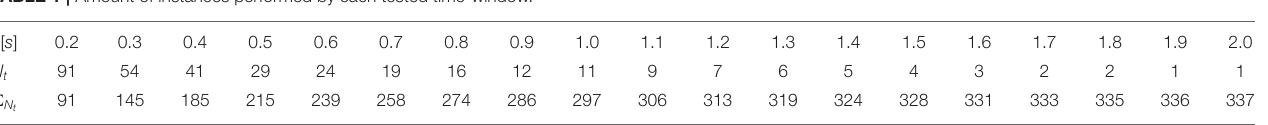
The last row reports the cumulative sum across all range of considered τ .